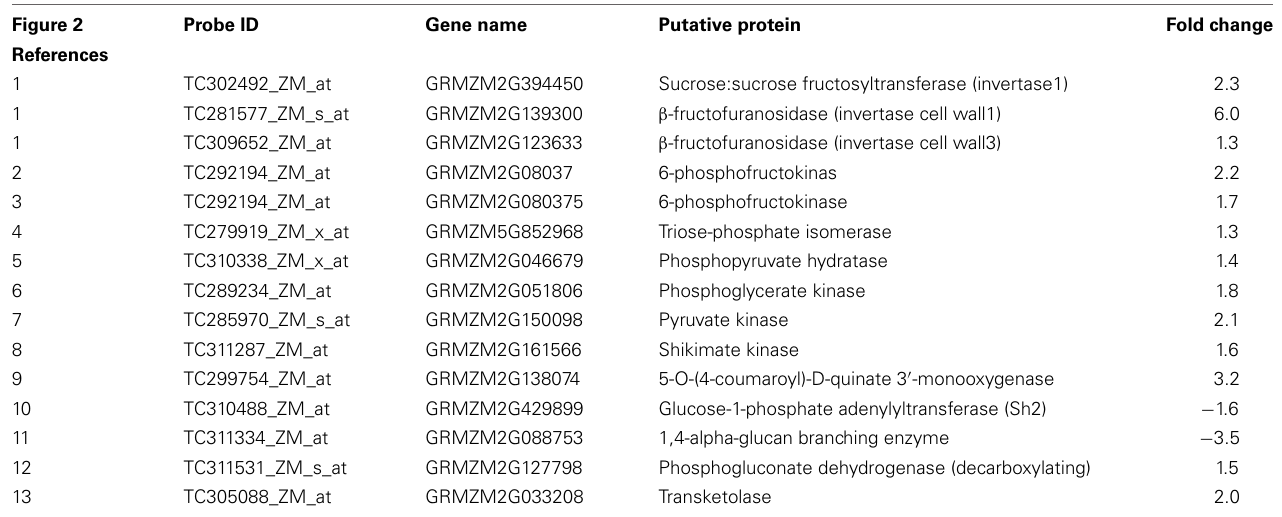
Table 2 | Statistically significant differentially expressed genes referenced in Figure